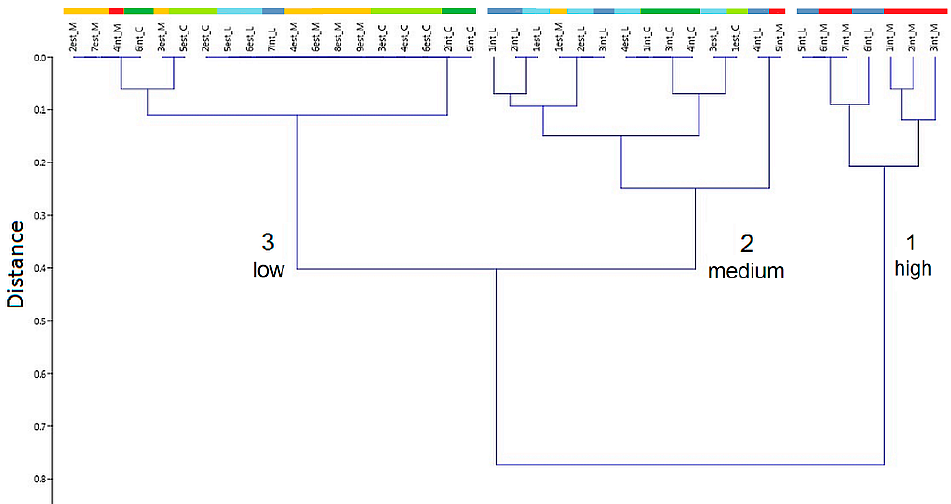
Figure 5. Tree diagram provided by cluster analysis using the pulse code to visualize which listening points were more similar in the Venice inlets; colored lines refer to points located at Malamocco internal side (red), Malamocco external sea side (orange), Lido internal side (blue), Lido external sea side (light blue), Chioggia internal side (green), and Chioggia external sea side (light green). The positions of the points in the inlets are highlighted in Figure 1 (black dots are used for group coded “1,” dark grey dots are used for group coded “2,” and white dots are used for group coded “3”).